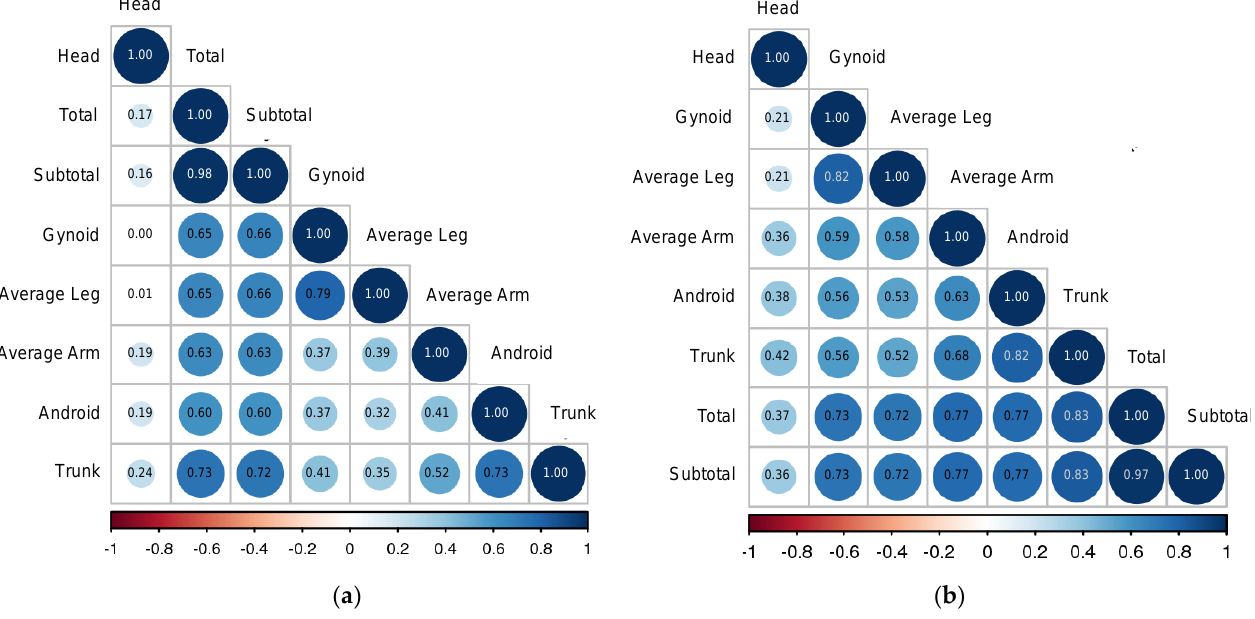
Table 4. Correlations between Regional Body Fat Measures in Obese Males and Females.